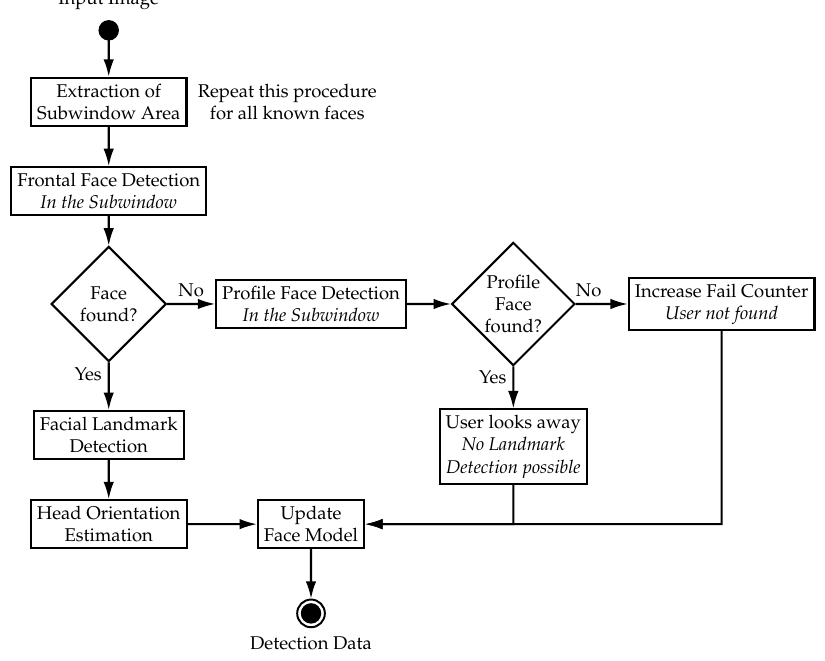
Figure 5. Decision tree of "After Recent Detection" mode. The rectangle shapes illustrate tasks of the algorithm and the diamond shapes symbolize decisions.